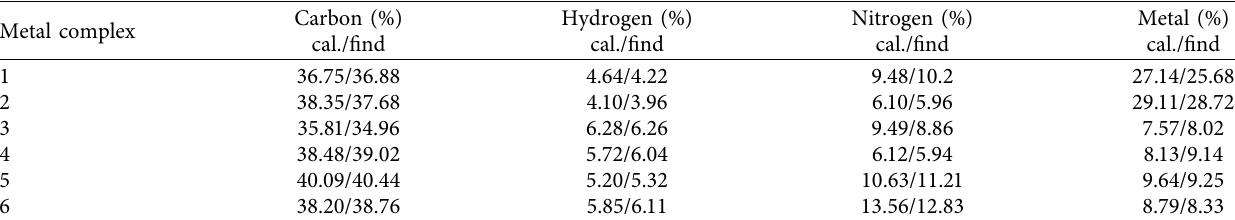
Table 4: Te elemental composition and metal ion content of the isolated solid